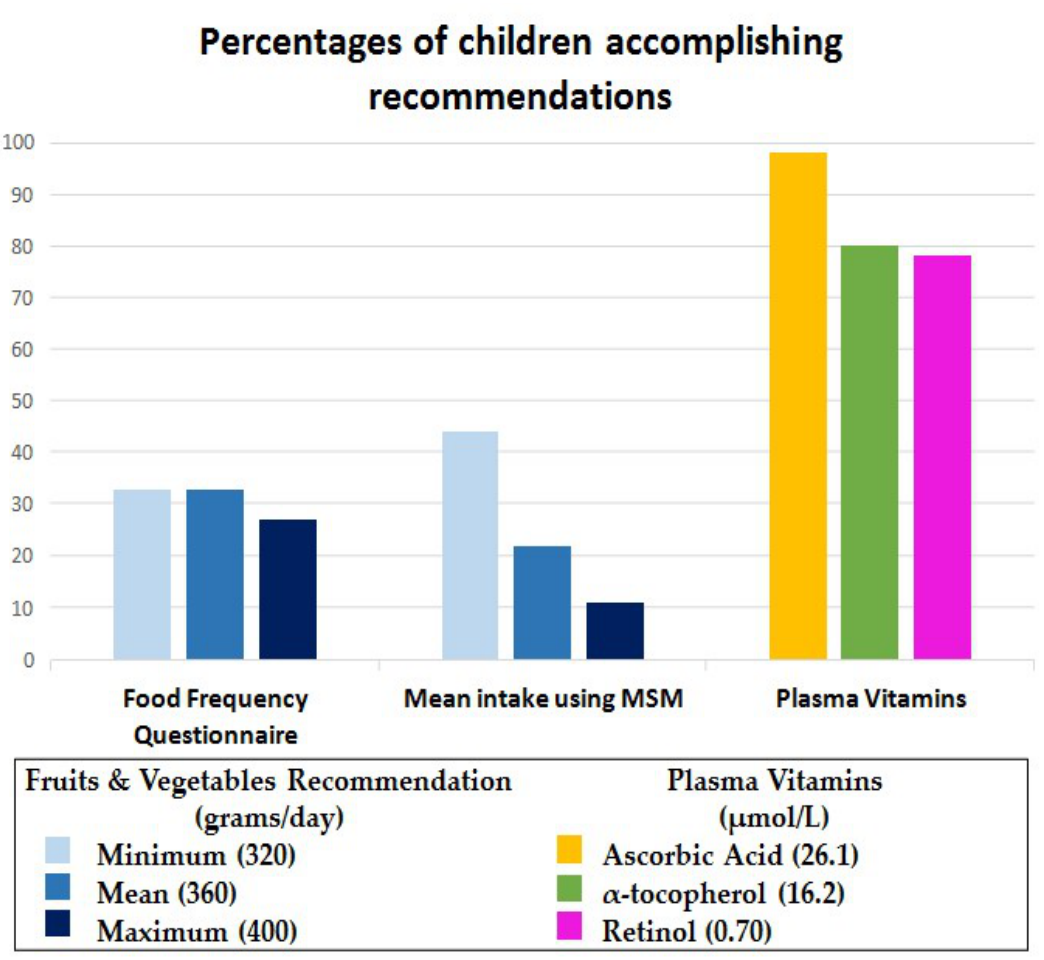
Figure 2. FFQ: Food frequency questionnaire; MSM: Multiple source method (the combination of frequency of intake with 3 days of 24-h Dietary Recall). These prevalences are based on adherence to the following recommendations: Fruits and vegetables [1]; ascorbic acid [31]; α -tocopherol [33]; retinol [32]. Percentages of accomplished recommendations for children’s (6–10 years) fruit and vegetable intake and plasma vitamins.